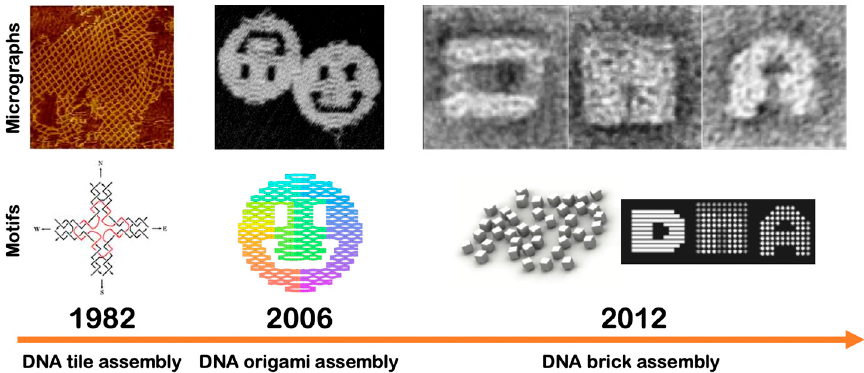
Figure 4. Three fundamental DNA self-assembly approaches for the design of precise DNA nanostructures are DNA tile assembly, DNA origami assembly, and DNA brick assembly with respect to the historical perspective. A representative micrograph of DNA lattices which are made from self-assembled distinct individual DNA tiles whereas DNA origami smiley faces are made from several hundred self-assembled short single-stranded DNA oligomers with a 7-kilobase scaffolded DNA strand. A micrograph of 3D DNA bricks which are made from the same 3D canvas, spells out the word “DNA”. Adapted with permission from [105]. Copyright 2003, DNA9. Adapted with permission from [106]. Copyright 2006, Springer Nature. Adapted with permission from [107].